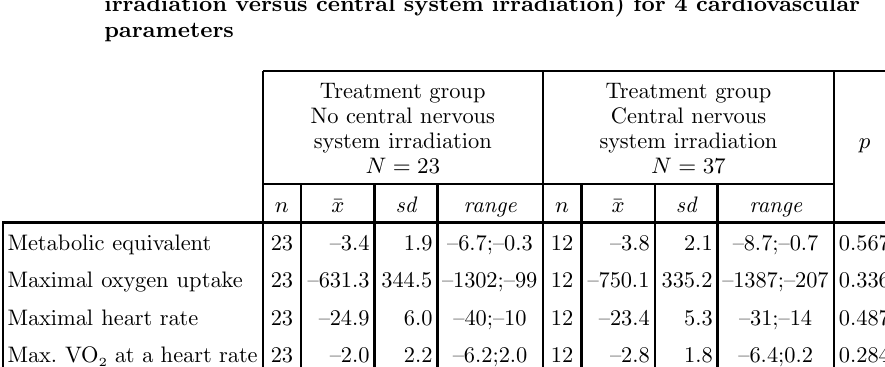
Table 7. Comparisons between two groups (no central nervous